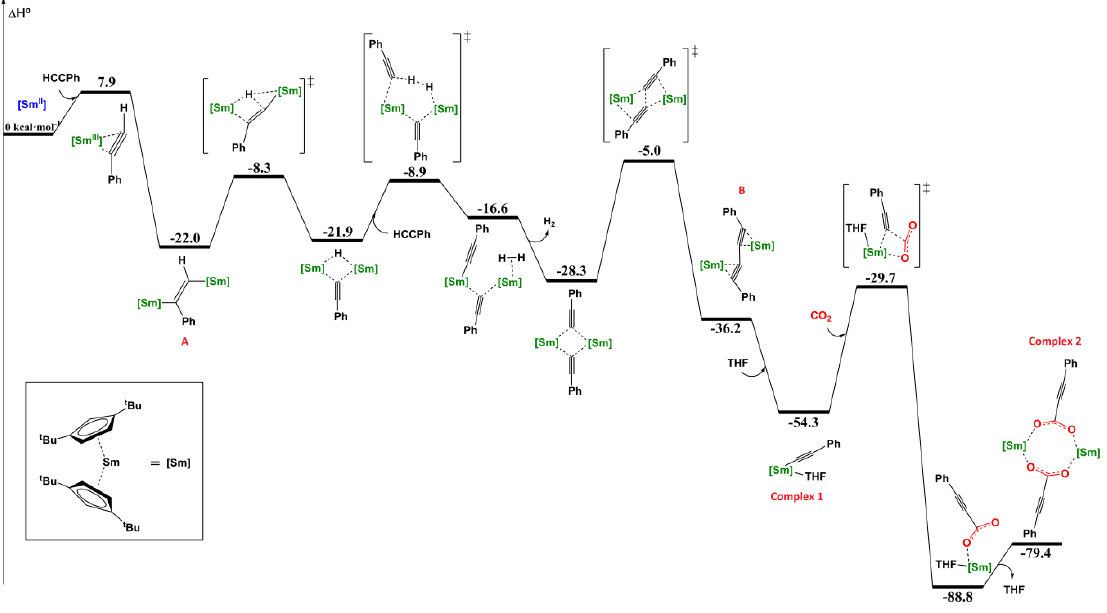
Figure 4. Energy profile of CO 2 insertion pathway for the complex Cp tt2 Sm(C ≡ C–Ph)(thf) ( 1